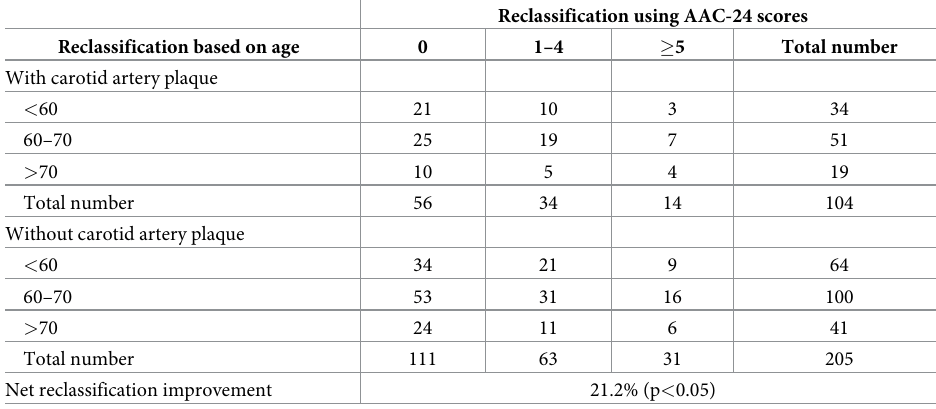
Table 6. Reclassification of the total cohort based on models using age and AAC-24 scores in subjects with or without carotid artery